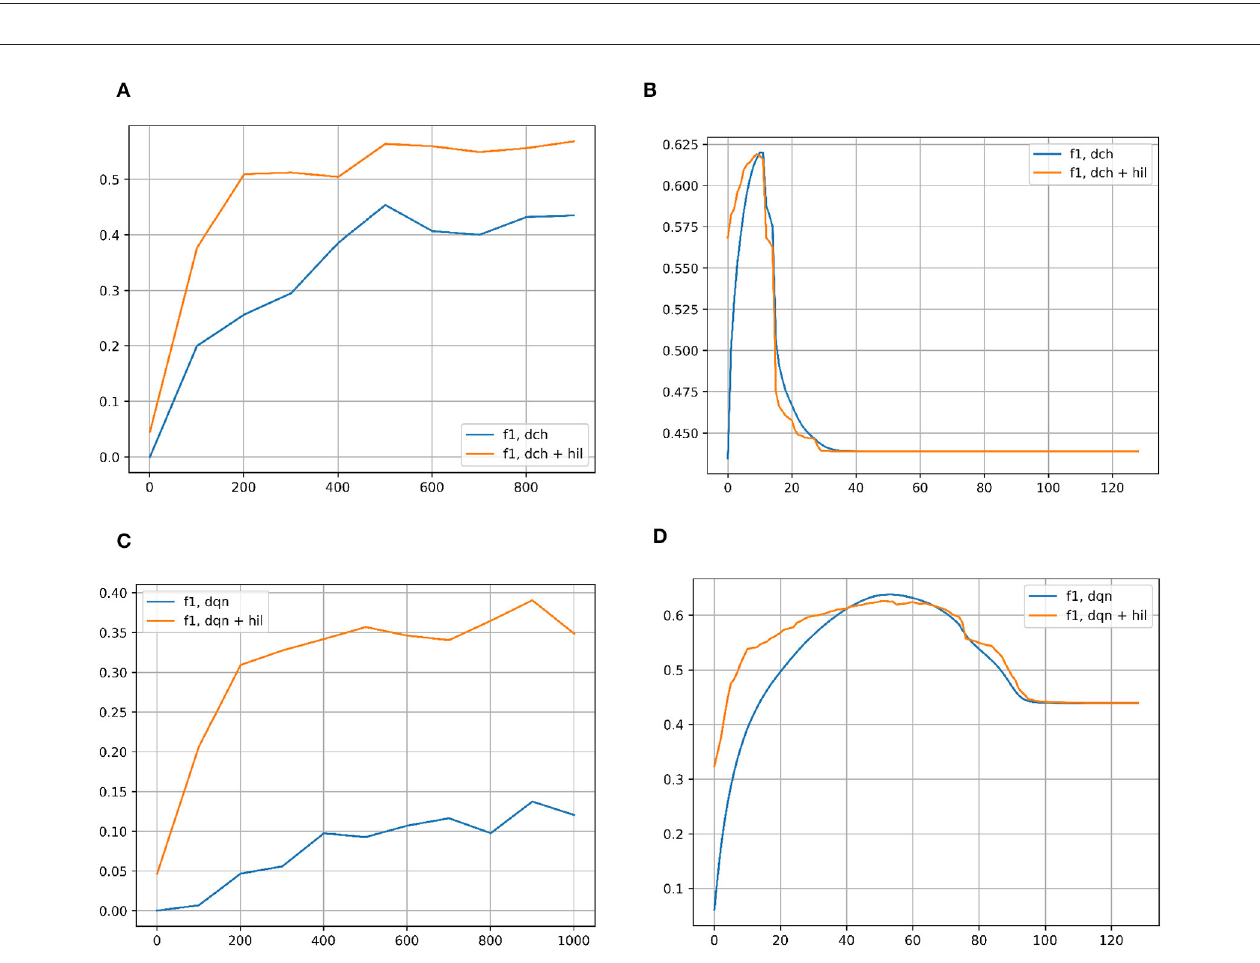
FIGURE 6 | achieving a higher performance in far fewer iterations of expensive network training. As the HIL adds negligible overhead in memory/computation time, there is no downside to using a HIL. The right column of results show that the HIL prevents the need for searching for an optimal Hamming Distance threshold to classify with, as it supercedes peak performance of the network right away for the lowest possible distance thresholds. After peak performance of the baseline network, larger Hamming Distance thresholds eventually decay to the performance of the baseline.